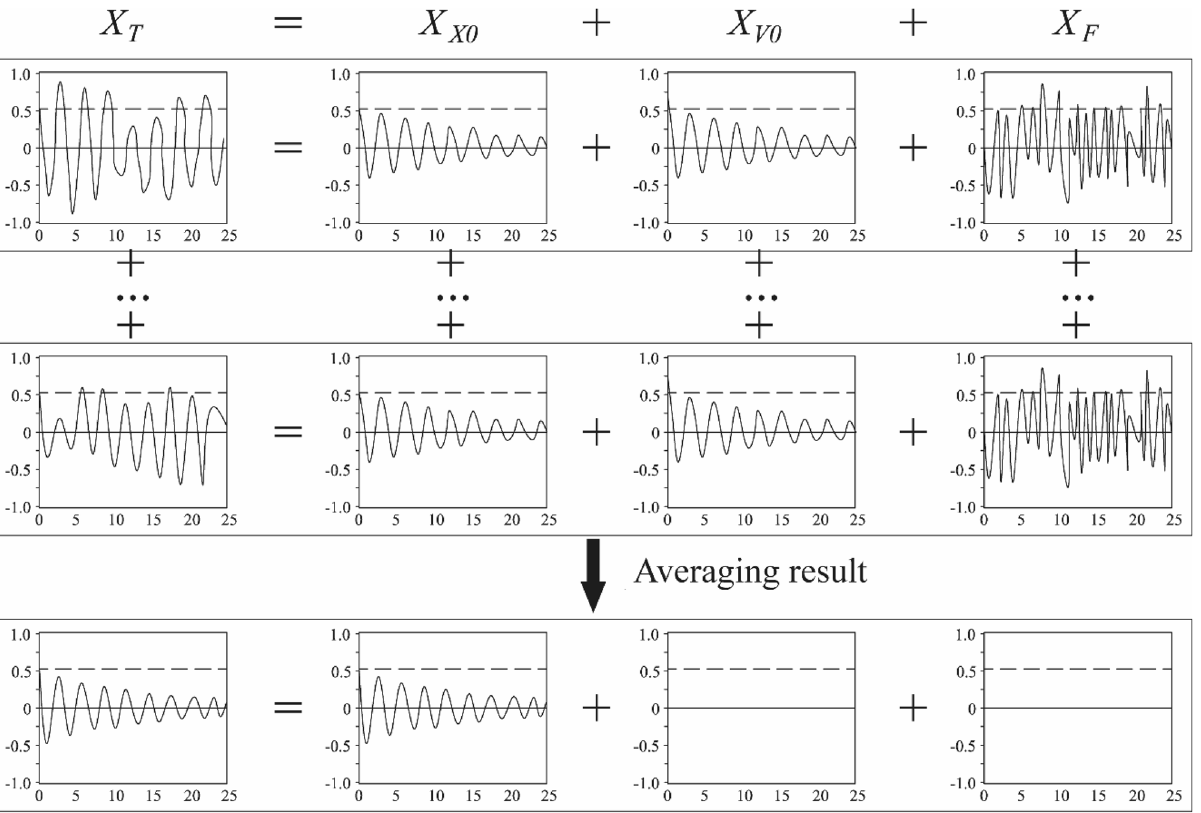
Figure 5. Conceptualization of RDT technique.